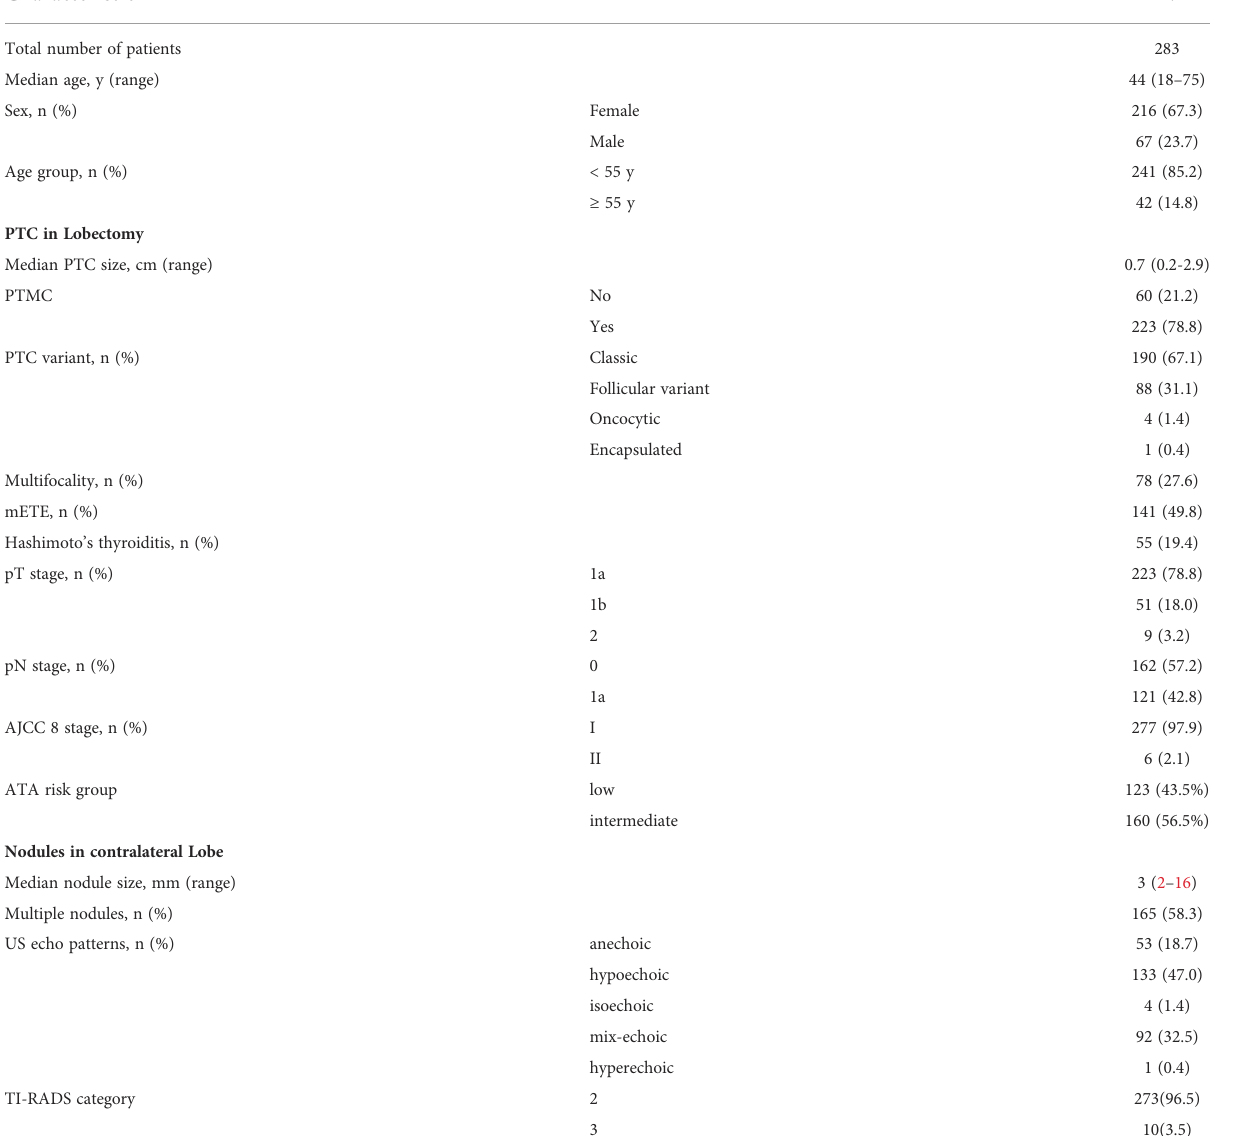
TABLE 1 Baseline